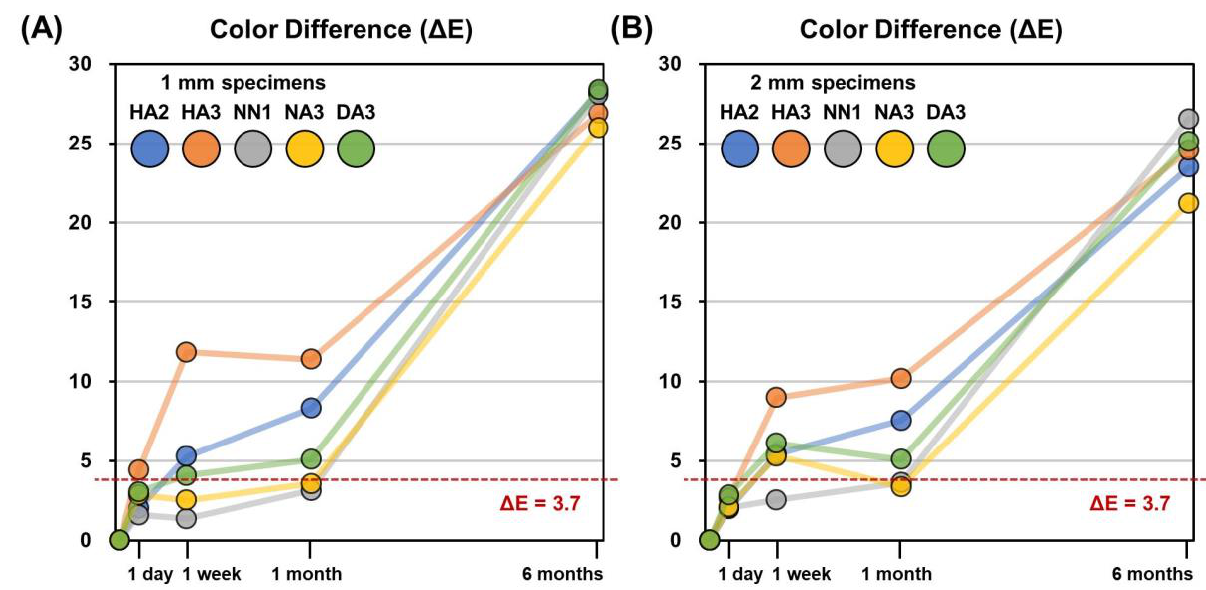
Figure 3. Mean color differences (ΔE) of the 3D printable material specimens after different storage periods compared to the 1 h color measurements. ( A ) 1 mm specimens. ( B ) 2 mm specimens.